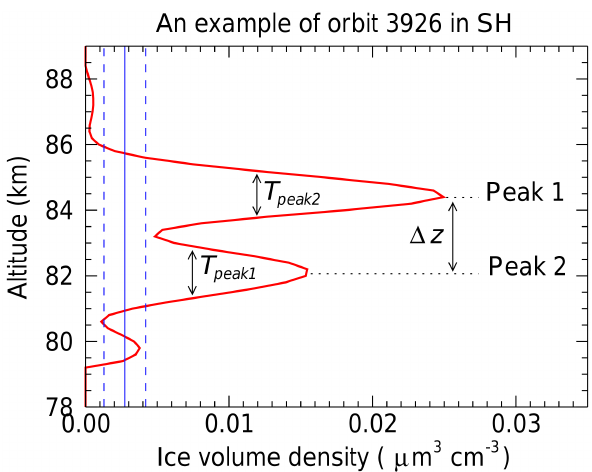
Figure 1. An example for extracting the double-layer event from ice volume density profile (red curve) of orbit number 3926 on 14 January 2008 in the SH. The blue solid line denotes the mean ice volume density for peaks of background weak PMCs, while both dashed lines are 1 standard deviation. T peak-1 and T peak-2 represent cloud thickness, while (cid:49) z is the distance between the identified two